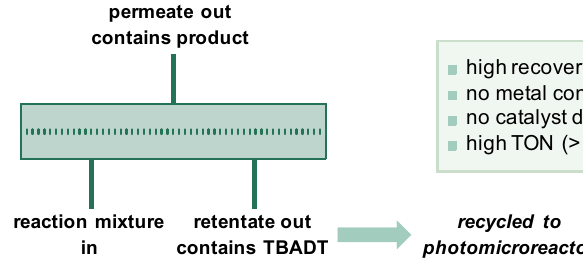
Fig. 1 | Overview detailing the importance of in-line TBADT recovery. a Photocatalytic Hydrogen Atom Transfer enables both early- and late-stage func- tionalization of hydroalkanes and biologically active compounds. b Small-scale versus large-scale synthetic organic chemistry requires different approaches: cat- alyst lifetime and cost are only relevant on a process chemistry level. c TBADT is a